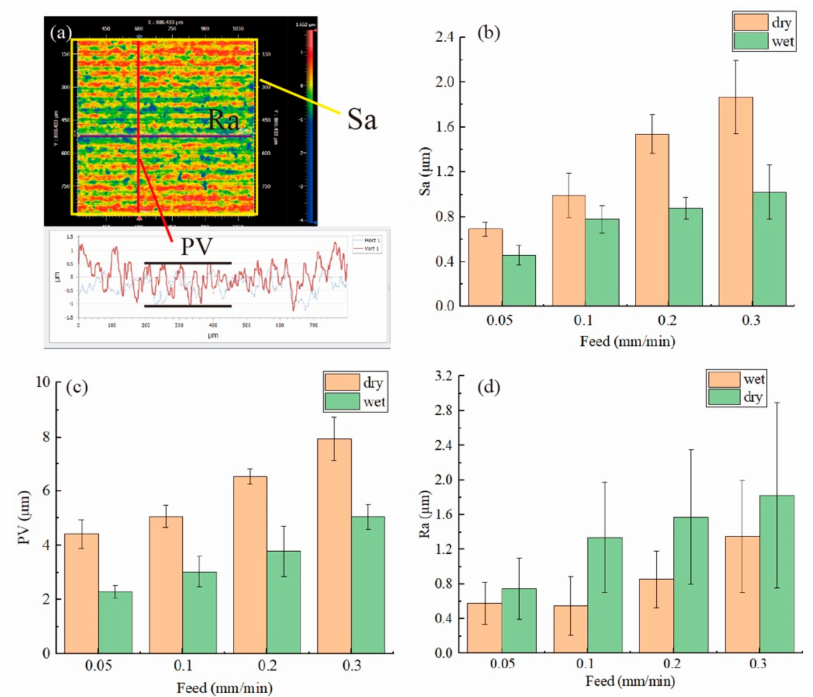
Figure 9. ( a ) A schematic of how all data were extracted from white light interferometer images; the surface roughness ( b ) Sa, ( c ) PV vertical to the saw mark and ( d ) Ra along the saw